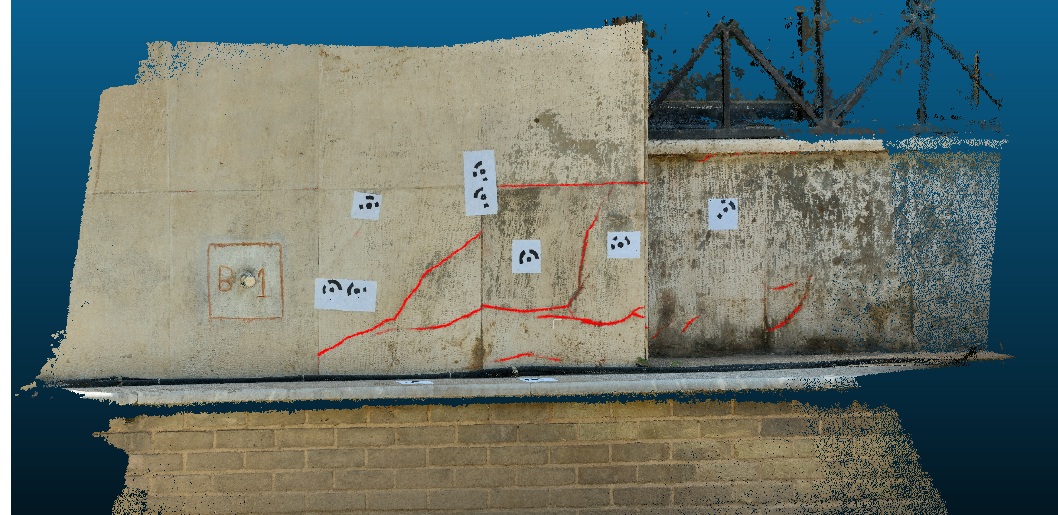
Figure 8. Segmented point cloud including crack points in true